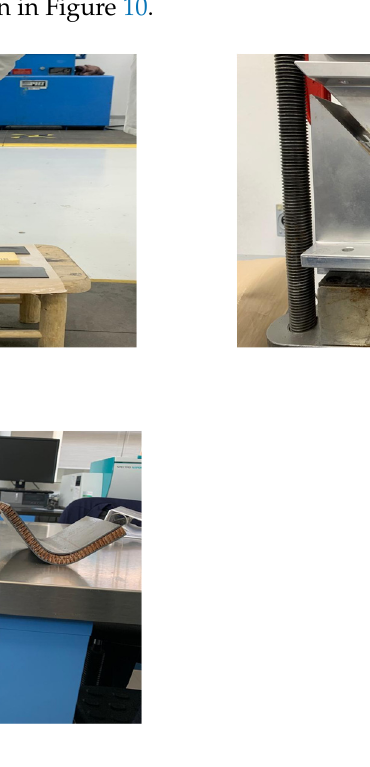
( c ) Figure 11. Pictures of the three ‐ point bending test performed to ( a ) ABS/HC/ABS, ( b ) ABS/Foam/ABS, and ( c ) ABS/griding foam/ABS. The pictures present the damages that occurred during the test. Based on the results, it is possible to suggest that the core acts actively more than the panels with GF prepreg in panels with ABS as face sheets. After the first delamination of the ABS, the load applied is supported by the core. That is the reason the ABS/HC/ABS presents lower mechanical performance than ABS/Foam/ABS. The foam is more rigid than HC. Considering the V ‐ shape of the specimens, the HC under this configuration is less restrictive than the foam.